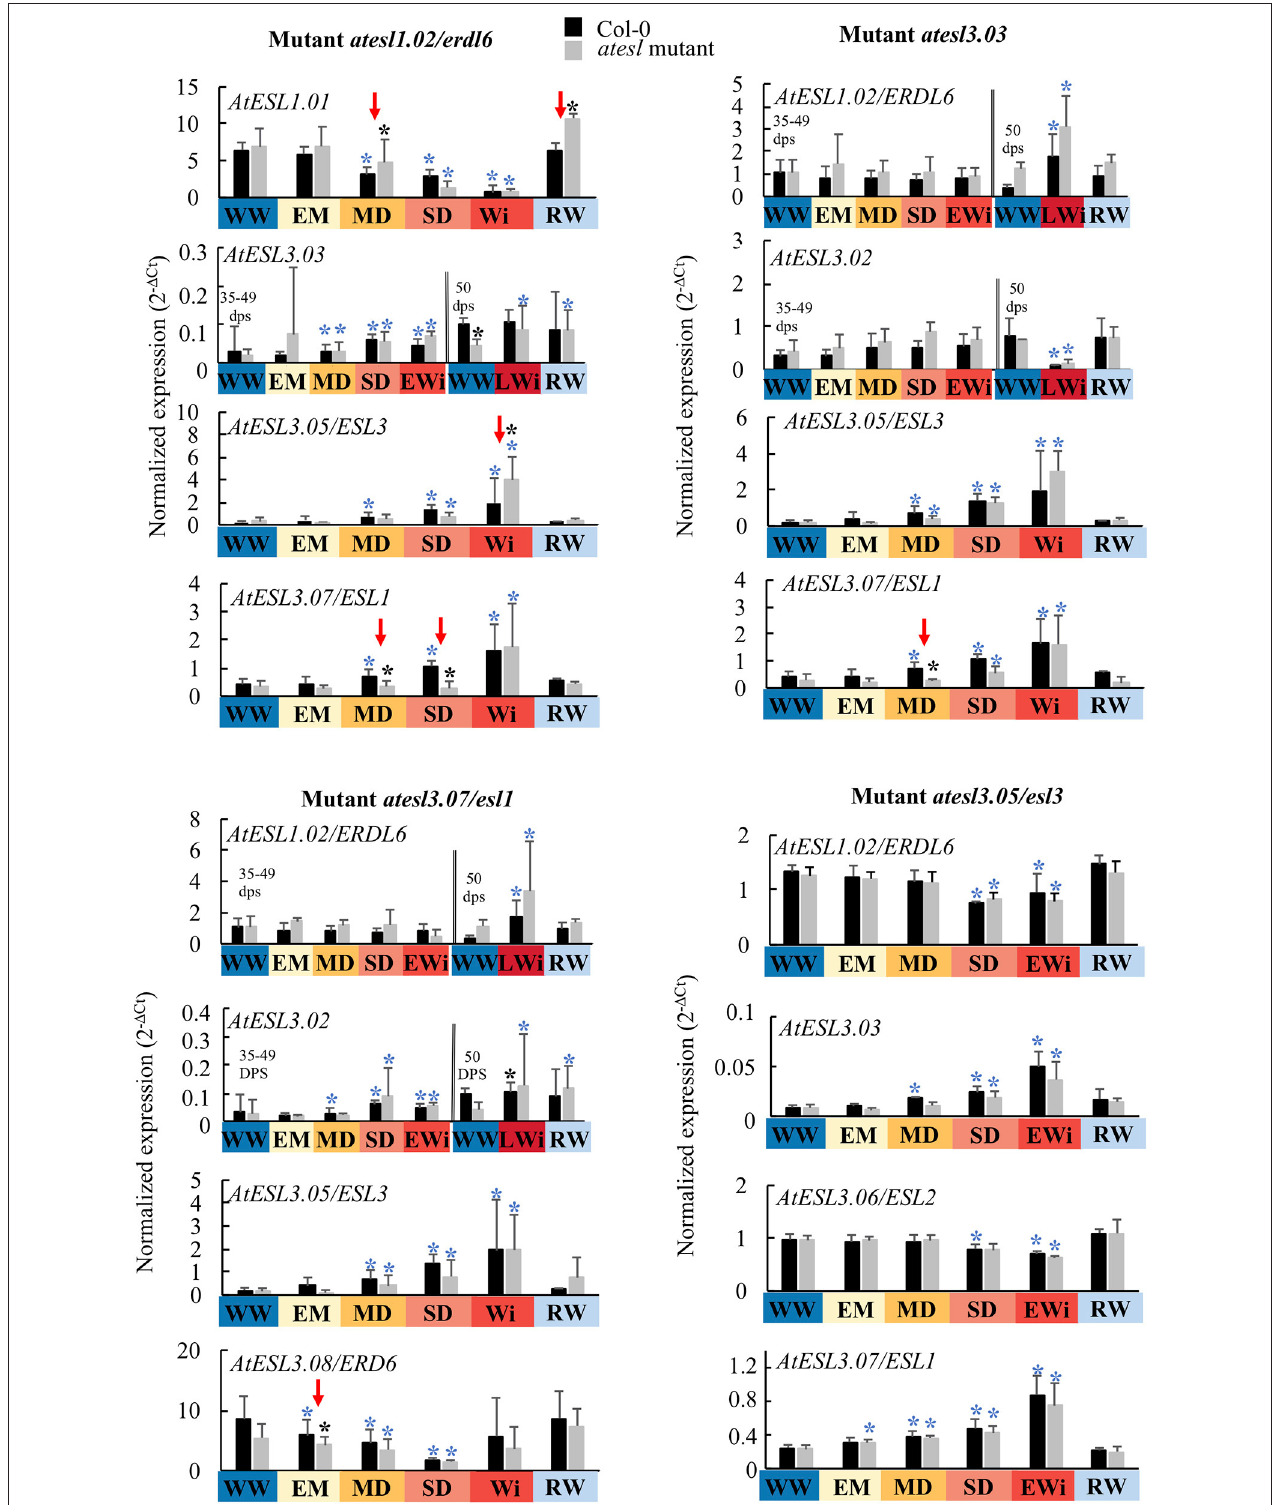
FIGURE 9 | Expression level of AtESL in the atesl mutants ( atest1.02/erdl6 , atesl3.03 , atesl3.05/esl3 , and atesl3.07/esl1 ) in WW, WD, and RW plants compared to Col-0 plants as a function of the four phases of water deficit: EM, early mild water deficit; MD, moderate water deficit; SD, severe water deficit; EWi, early wilting;